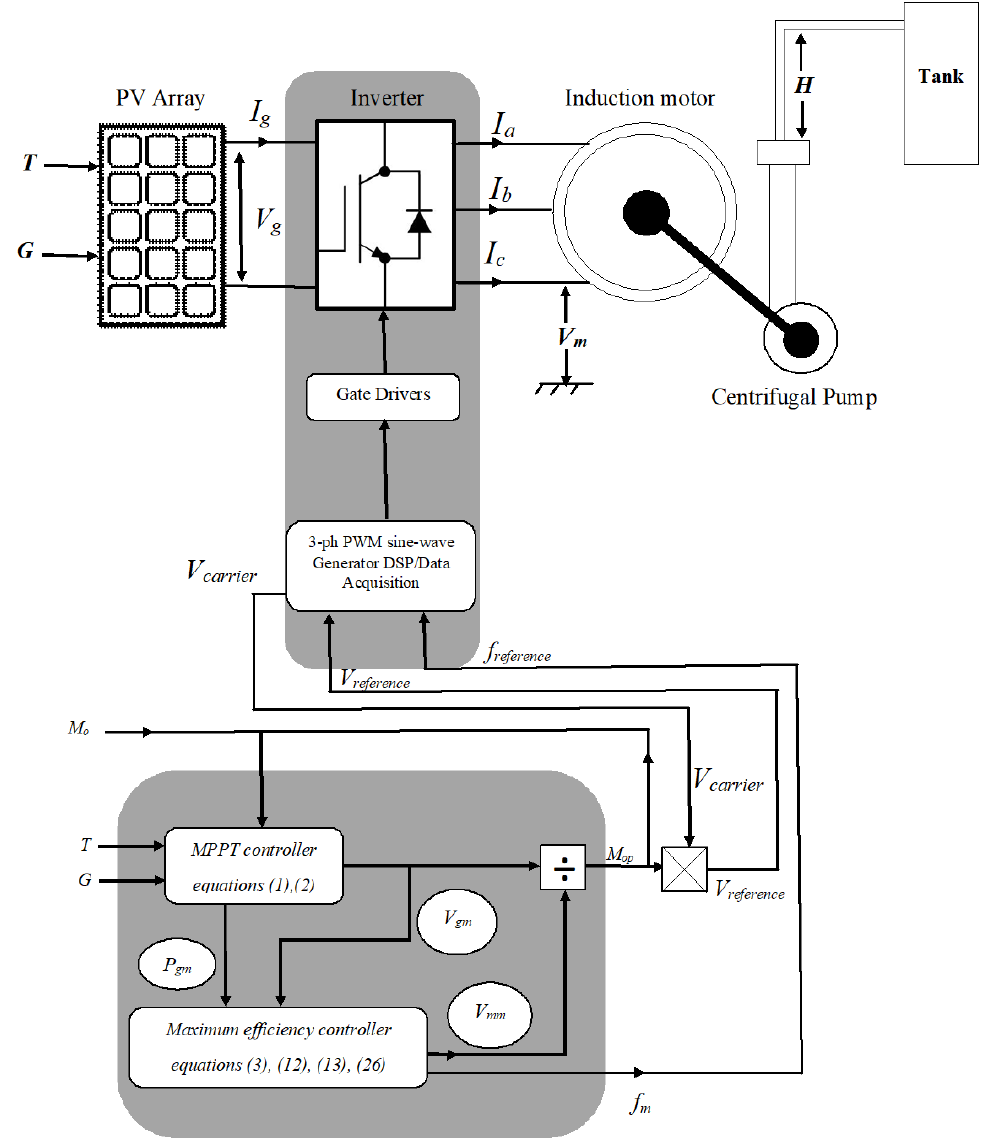
Figure 1. The schematic diagram for the PV-MPPT at IM maximum efficiency controlling process.